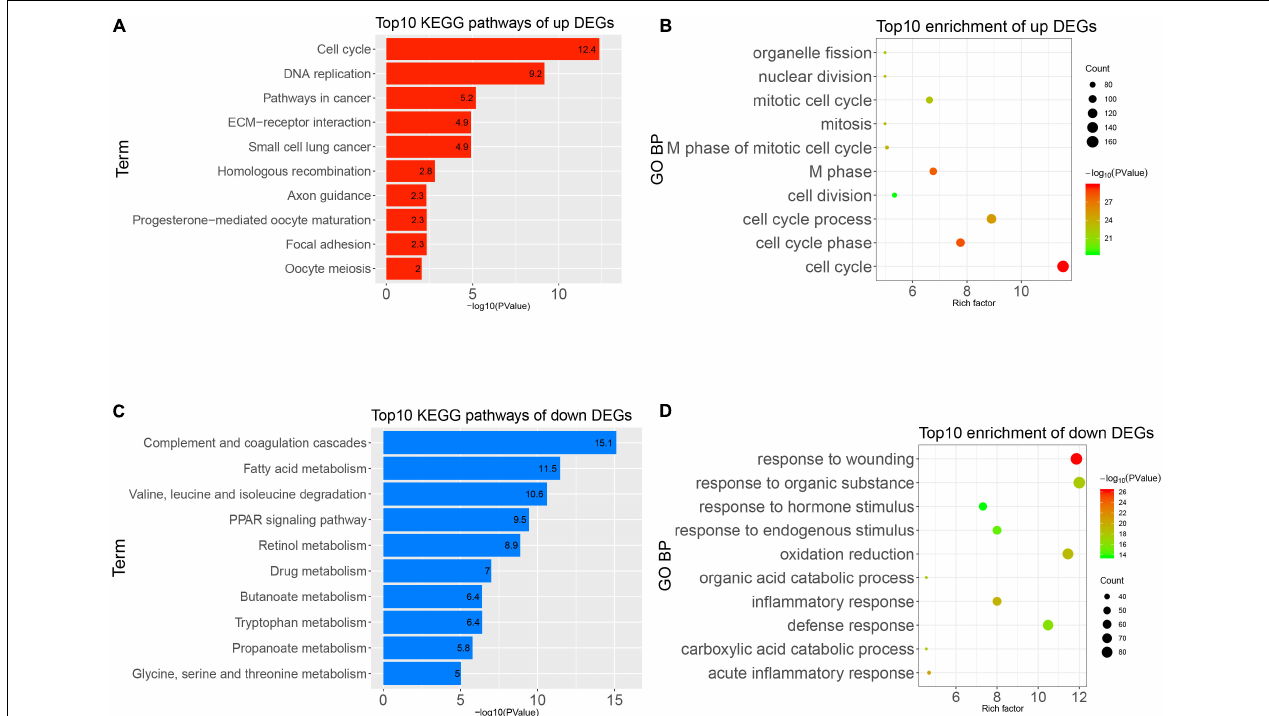
FIGURE 3 | Gene Ontology (GO) and Kyoto Encyclopedia of Genes and Genomes (KEGG) pathways analysis of all differentially expressed genes (DEGs). (A) Top 10 enrichments of up-regulated DEGs by GO biological process. (B) Top 10 KEGG pathways of up-regulated DEGs. (C) Top 10 enrichment of down-regulated DEGs by GO biological process. (D) Top 10 KEGG pathways of down-regulated